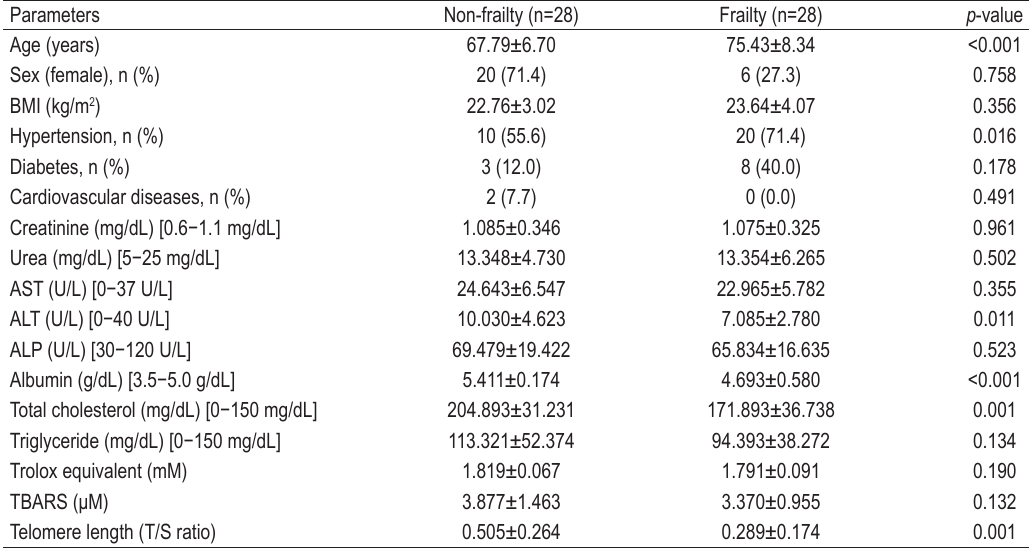
TABLE 1. Mean±standard deviation of clinical parameters of older adults in non-frailty and frailty groups Parameters